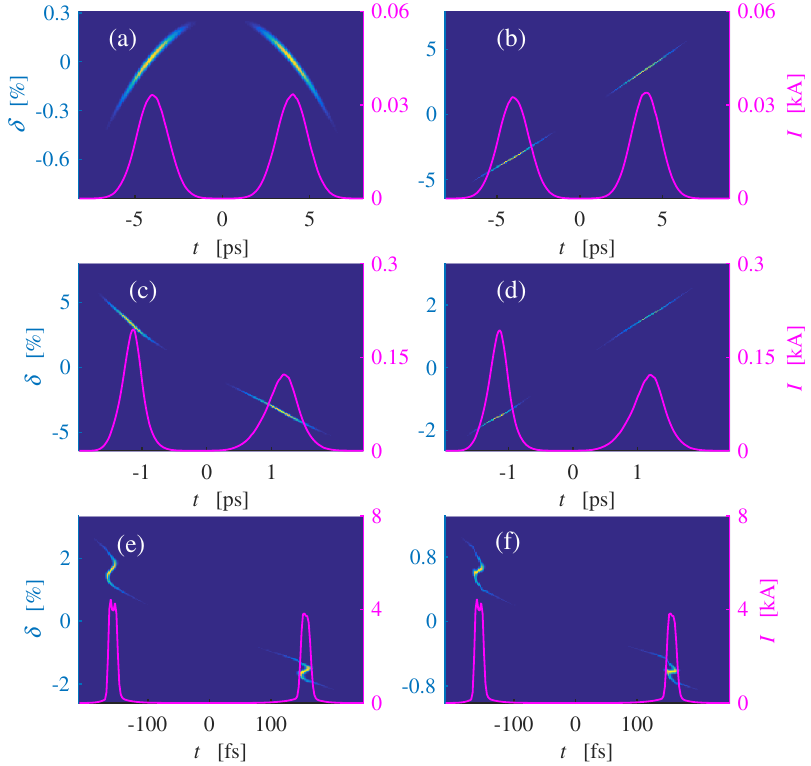
FIG. 6. Longitudinal phase space evolution with current profile without the delay chicane: (a) Injector exit; (b) BC1 entrance; (c) BC1 end; (d) BC2 entrance; (e) BC2 end; (f) L3 end. The head bunch lies left. The L1 phase is − 35 . 5 ° and the L2 phase is − 41 . 7